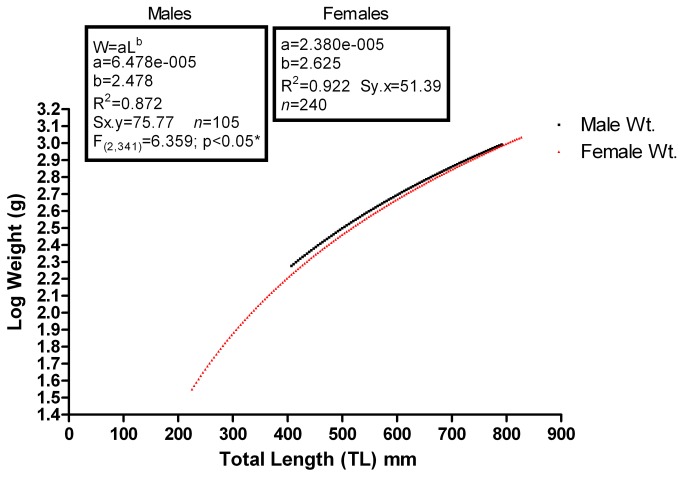
A comparison of male and female L:W curves.The curves are significantly different but parallel, with males heavier than females at all TLs.